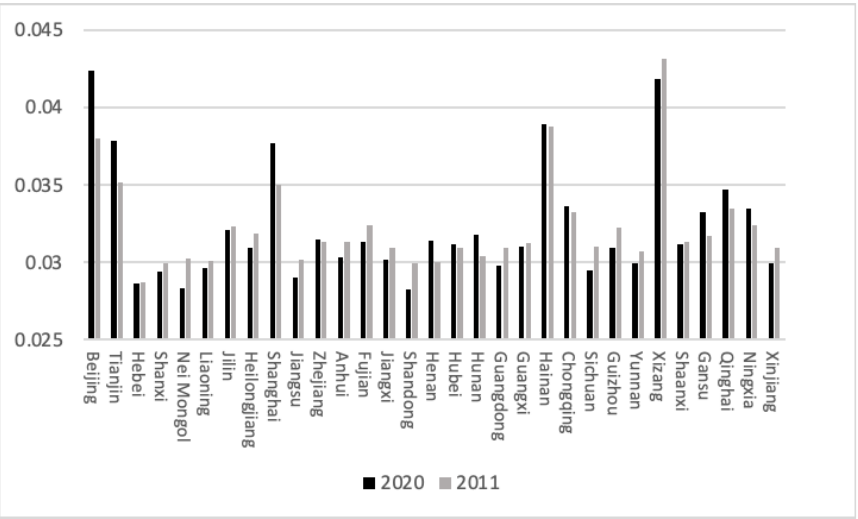
Figure 2. The effectiveness indicators of industrial pollution. (Source: made by the authors).